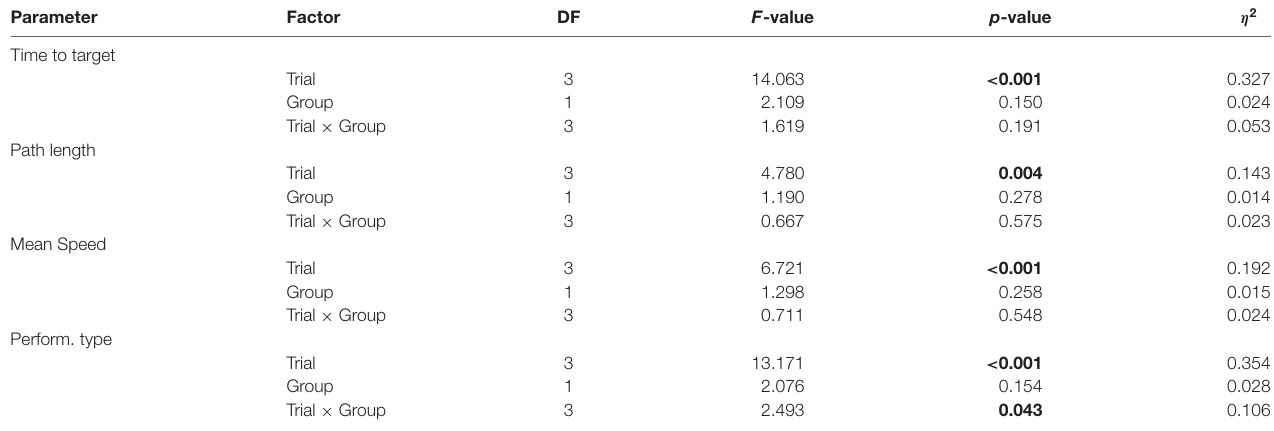
TABLE 5 | ANOVA results of the analysis of MWM data in case of iTBS applied to juvenile rats, using factors Group (MIA, controls) and trials (1–4). Parameter Factor Time to